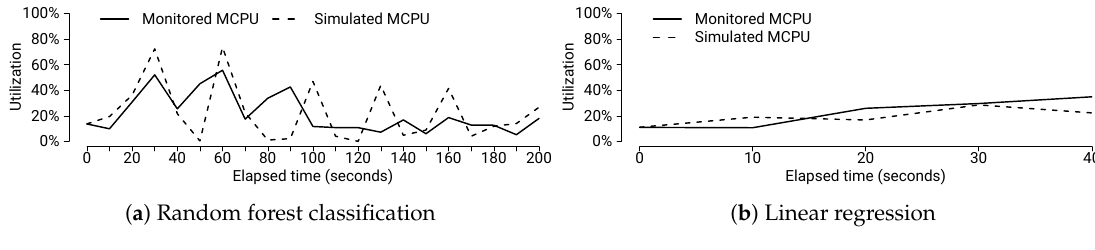
Figure 8. Mean CPU utilization of 16 worker nodes (small data